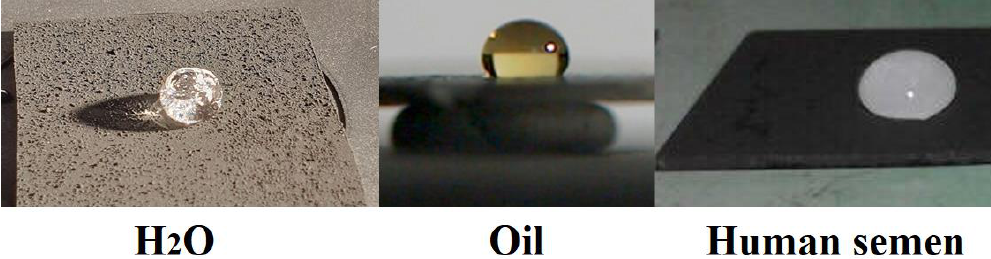
Figure 2. A photograph of typical super-nonwetting carbon soot coatings deposited via inexpensive and scalable flame synthesis approach [18,37,38].